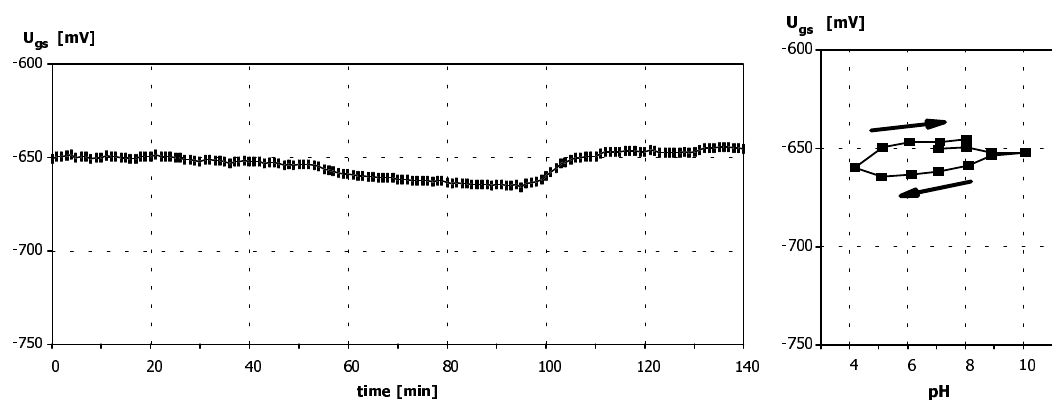
Figure 3. Dynamic response and calibration curve to pH of an ISFET with polyHEMA coating deposited according to the Method 2, with subsequently increased thickness by dropping of additional portion of HEMA cocktail by means of micropipette. Cycle of pH changes: 7-10-4-8. (Measurements performed for the same ISFET as in Fig. 3, but in restricted